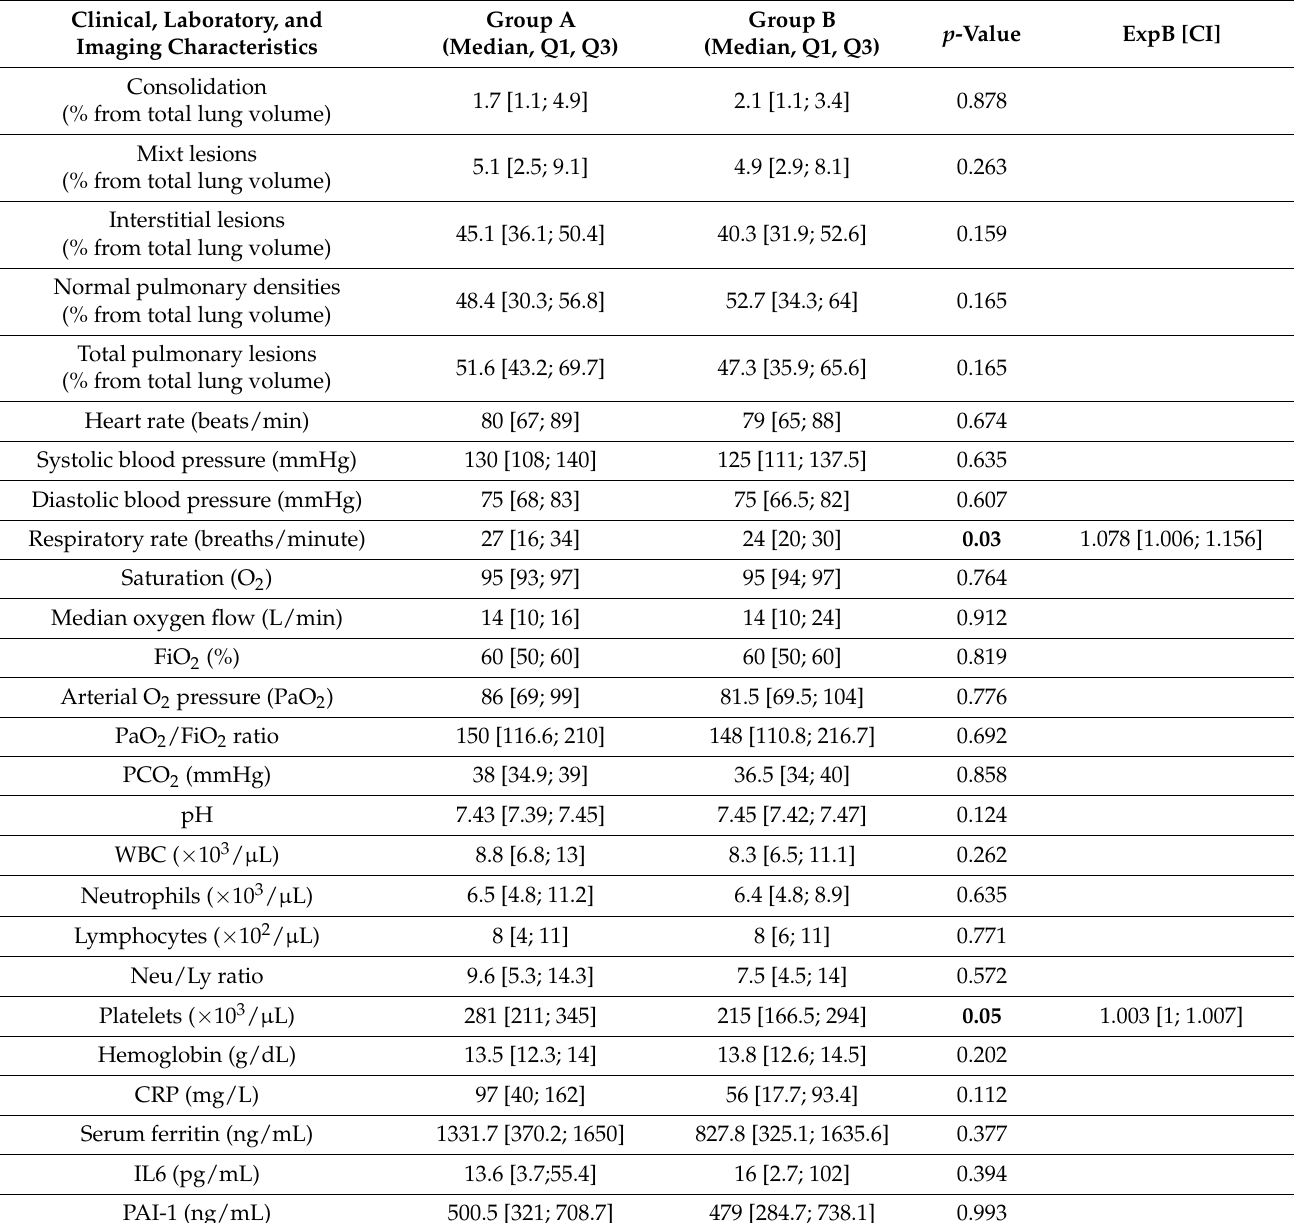
Patients with pericardial effusion had higher respiratory rates, coagulation parameters (D-dimers, PAI-1), leukocytes, inflammatory parameters (CRP, serum ferritin), and cardiac markers (myoglobin, CK, CK-MB, BNP, and LDH). We found no significant differences in the lung involvement between the two study groups (Table 2). Table 2. Clinical, laboratory, and imaging characteristics in SARS-CoV-2 patients with and without pericardial